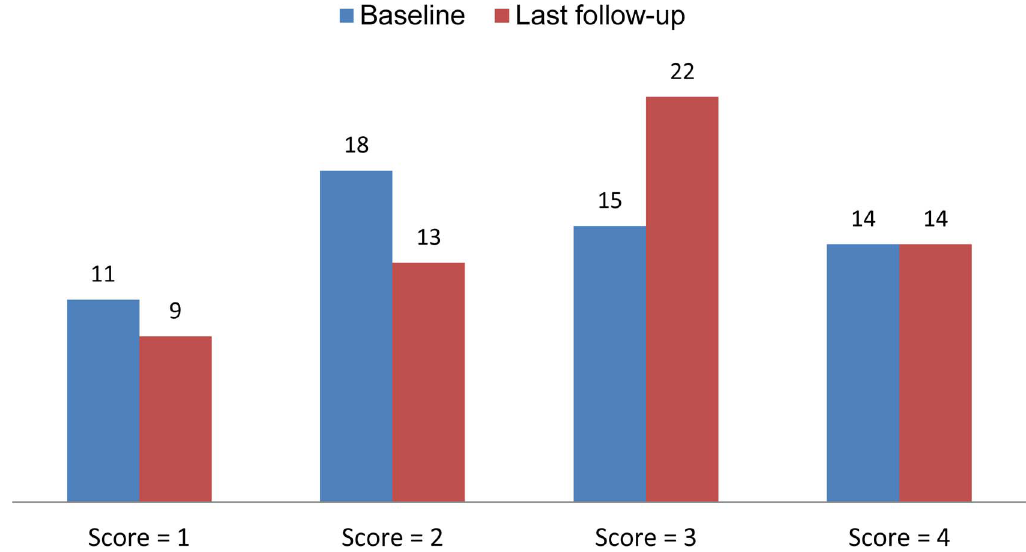
Fig. 2. The number changes of patients in each score of LVDD at baseline and last